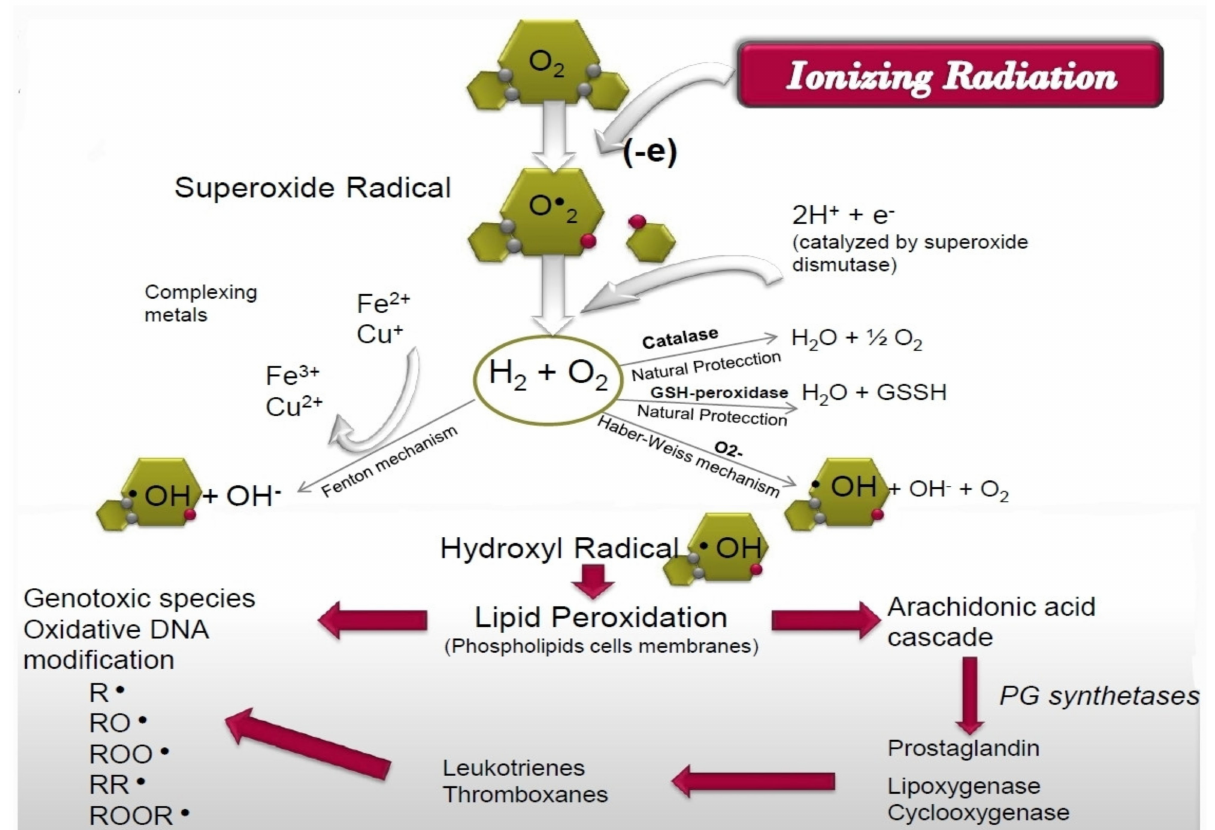
Figure 9. Schematic representation of the cellular injury mechanism of ionizing radiation-induced